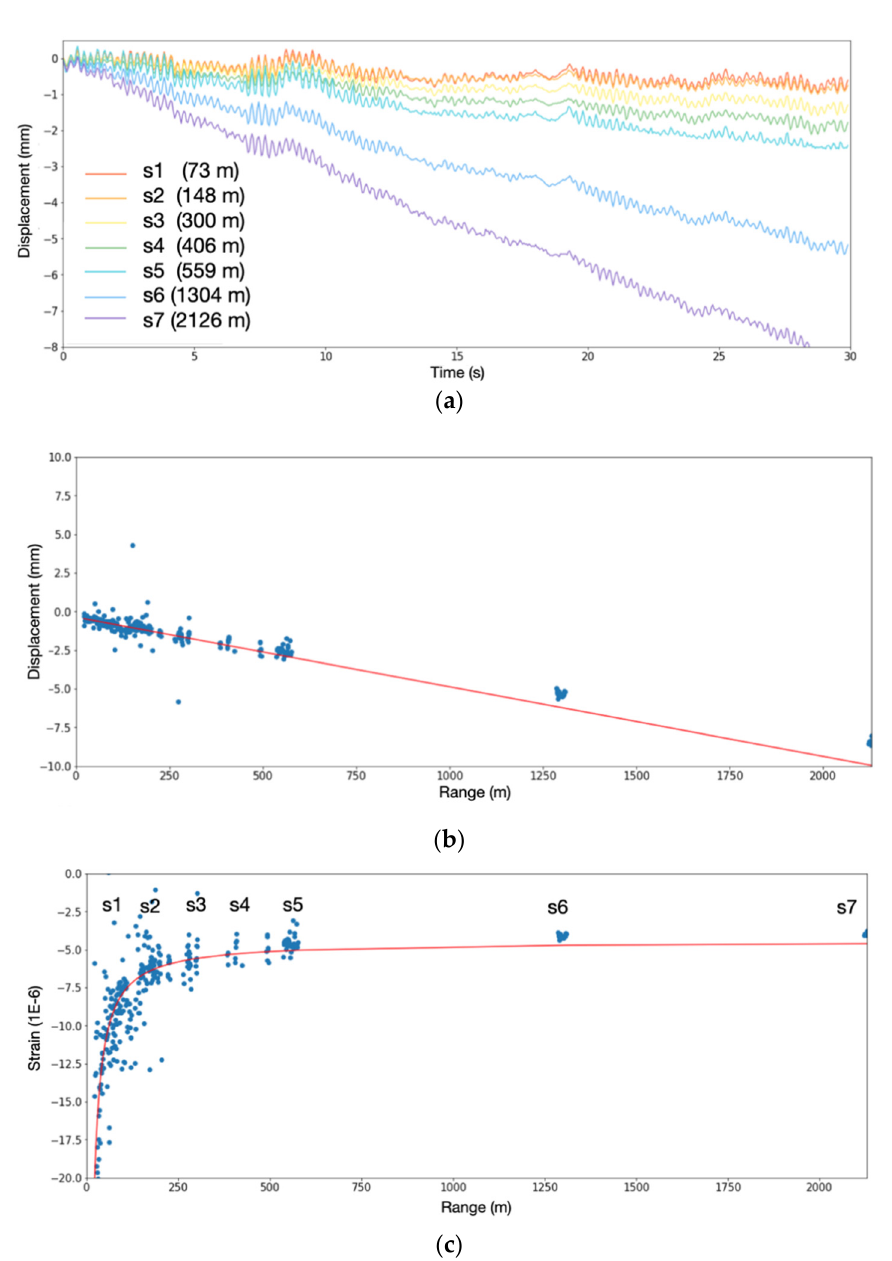
Figure 8. ( a ) Derived horizontal displacement of strong scatterers (s1–s7) distributed between near and far range. Total displacement ( b ) and strain ( c ) at last timestep for all scatterers exhibiting high (>0.98) coherence. Displacement in ( b ) indicates increasing displacement with distance. The slope indicates the average strain at 4.6 mm/km. The strain in ( c ) indicates a gradual tilting of the antenna of 0.3 mm during the time of the